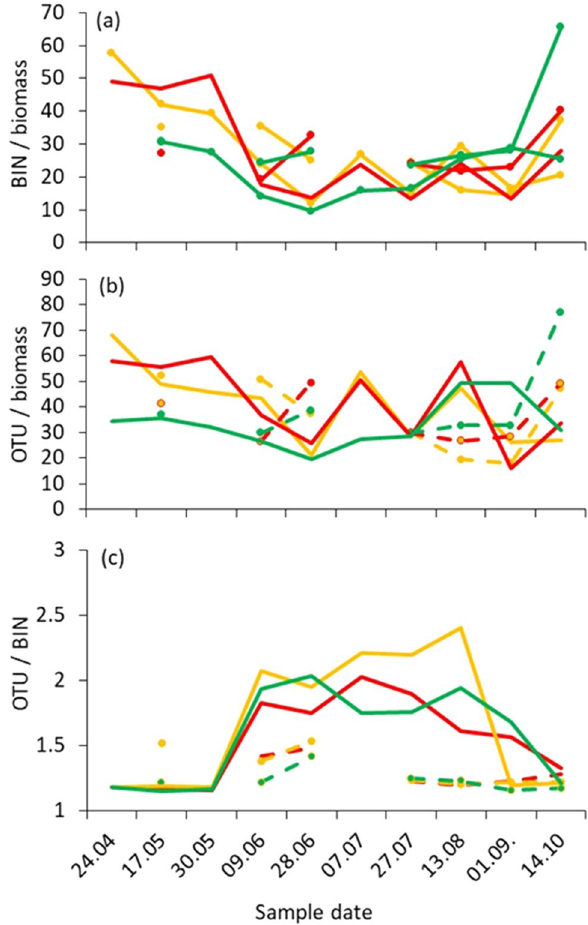
Figure 2. Annual time series of the BIN/biomass ( a ), OTU/biomass ( b ) and OTU/BIN ( c ) relationships for biological farming (green), recent change from conventional to organic farming (orange), and conventional farming (red). Continuous lines: 2019 sampling, broken lines: 2020